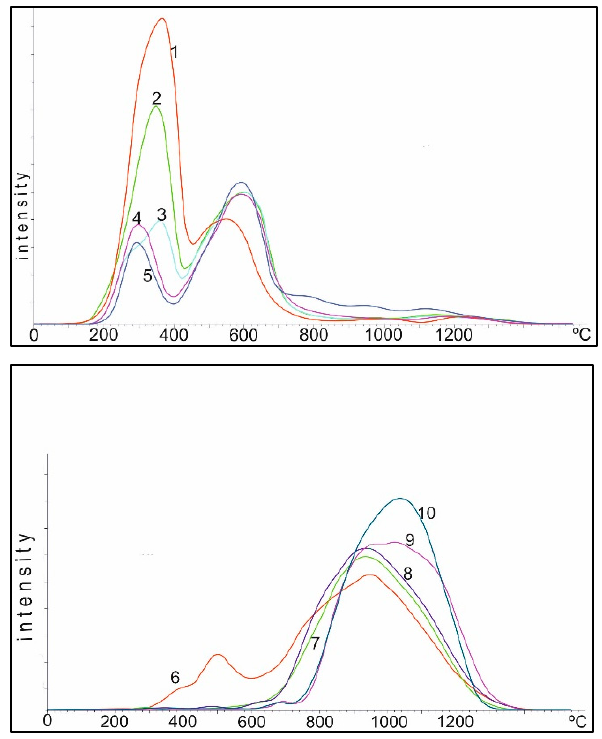
Figure 10. TPR data for 10% Co + 0.5% Pt / Al 2 O 3 calcined in air at 25–1100 ◦ C. 1. 25, 2. 300, 3. 400, 4. 550, 5. 650, 6. 750, 7. 800, 8. 850, 9. 950, 10. 1100 ◦ C. The intensity of the peaks of samples 6–10 is doubled.